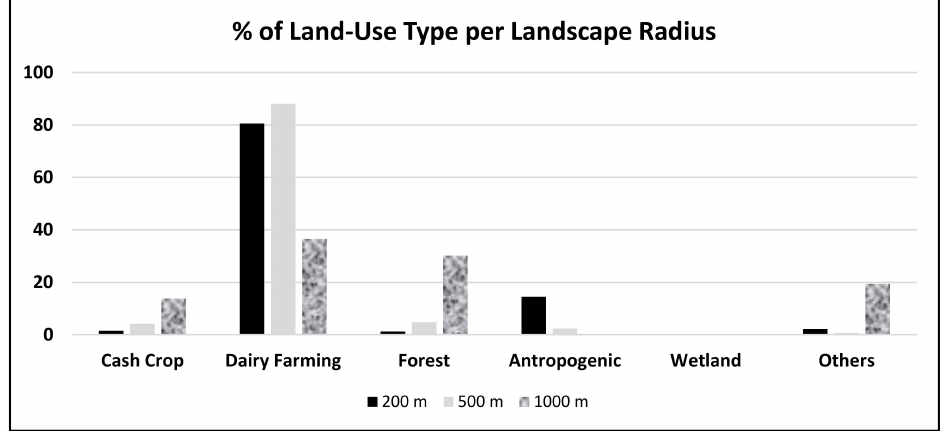
Figure 2. Percentage of land-use type per landscape radius surrounding the 61 farm ponds studied in the Boyer River watershed, St. Lawrence Valley lowlands, Southern Quebec (Canada). (1) Cash crops (cornfield, cereals, specialized crops, plowed fields); (2) dairy farming (hayfield, pastureland, old fields, abandoned cultivated land, or fallow non-cropped land); (3) forest (deciduous, mixed and coniferous forests, shrub or tree areas under regeneration, and alder stands); (4) anthropogenic (urban development, housing, roads); wetland (deep water, shallow waters, marsh, bogs, submerged vegetation); other (clouds, unclassified